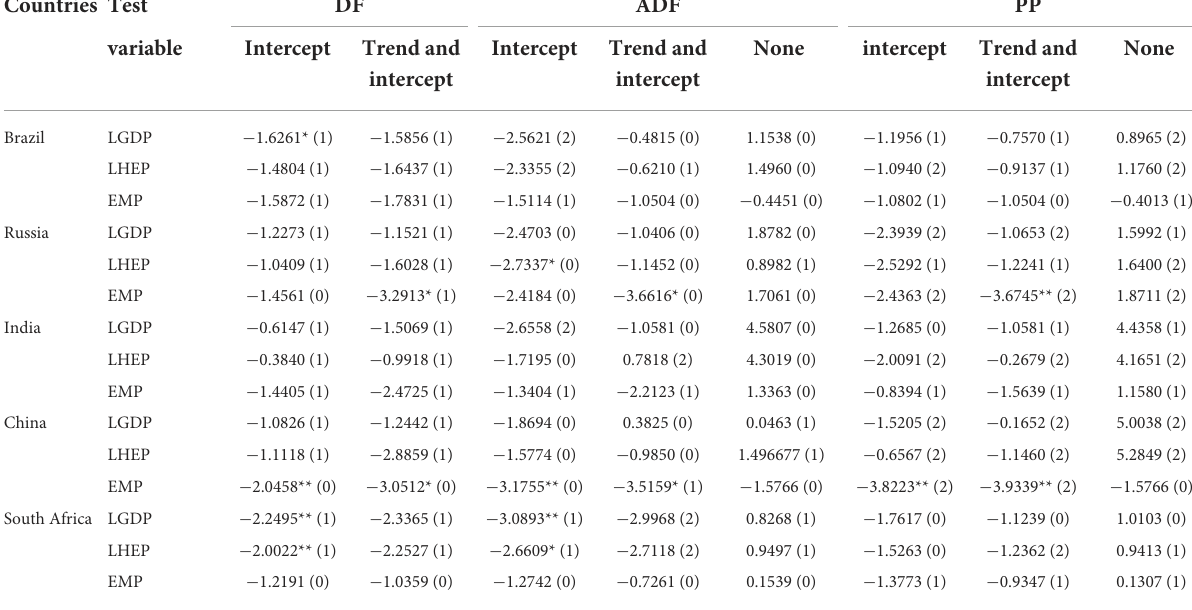
TABLE 3 Unit root test (Level term).